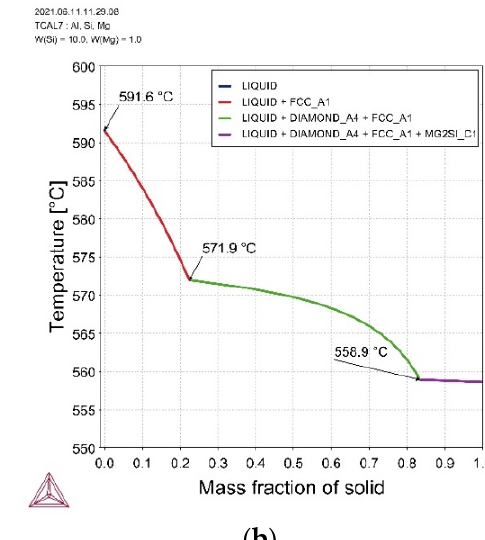
( d ) Figure 3. Representations in color maps of the evolution of growth velocities and cooling rates from top to bottom along the length of the solidified Al-Si-Mg bodies: ( a , b ) V L and ( c , d ) Ṫ for both examined alloys. 102030 4050607080 Al-10wt.% Si-1.0wt.% Mg P o s i t i on ( mm )